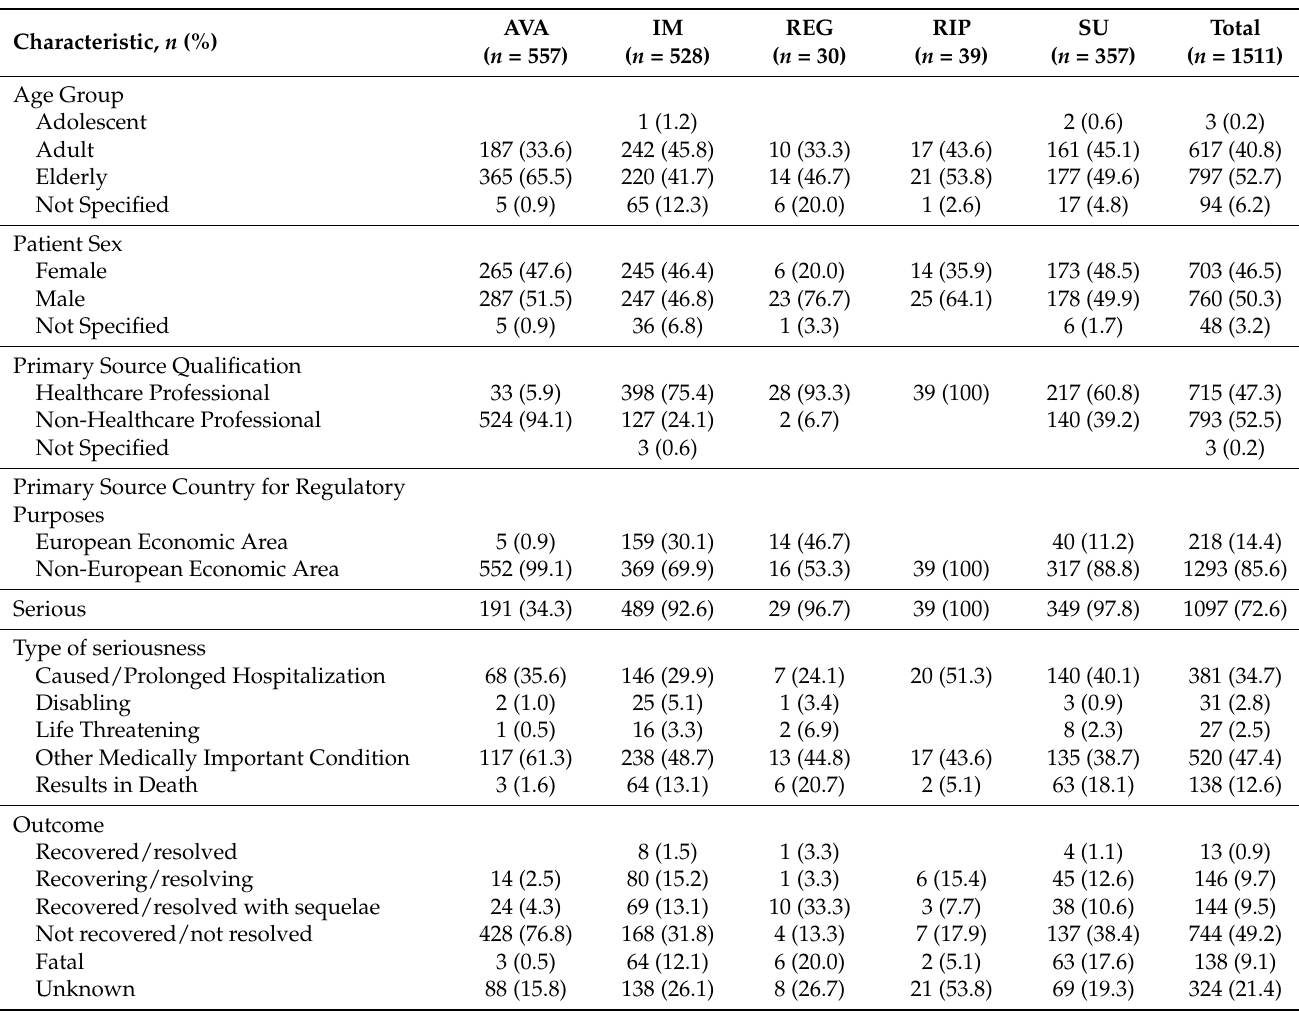
Table 3. Characteristics of TKI-related neuropsychiatric